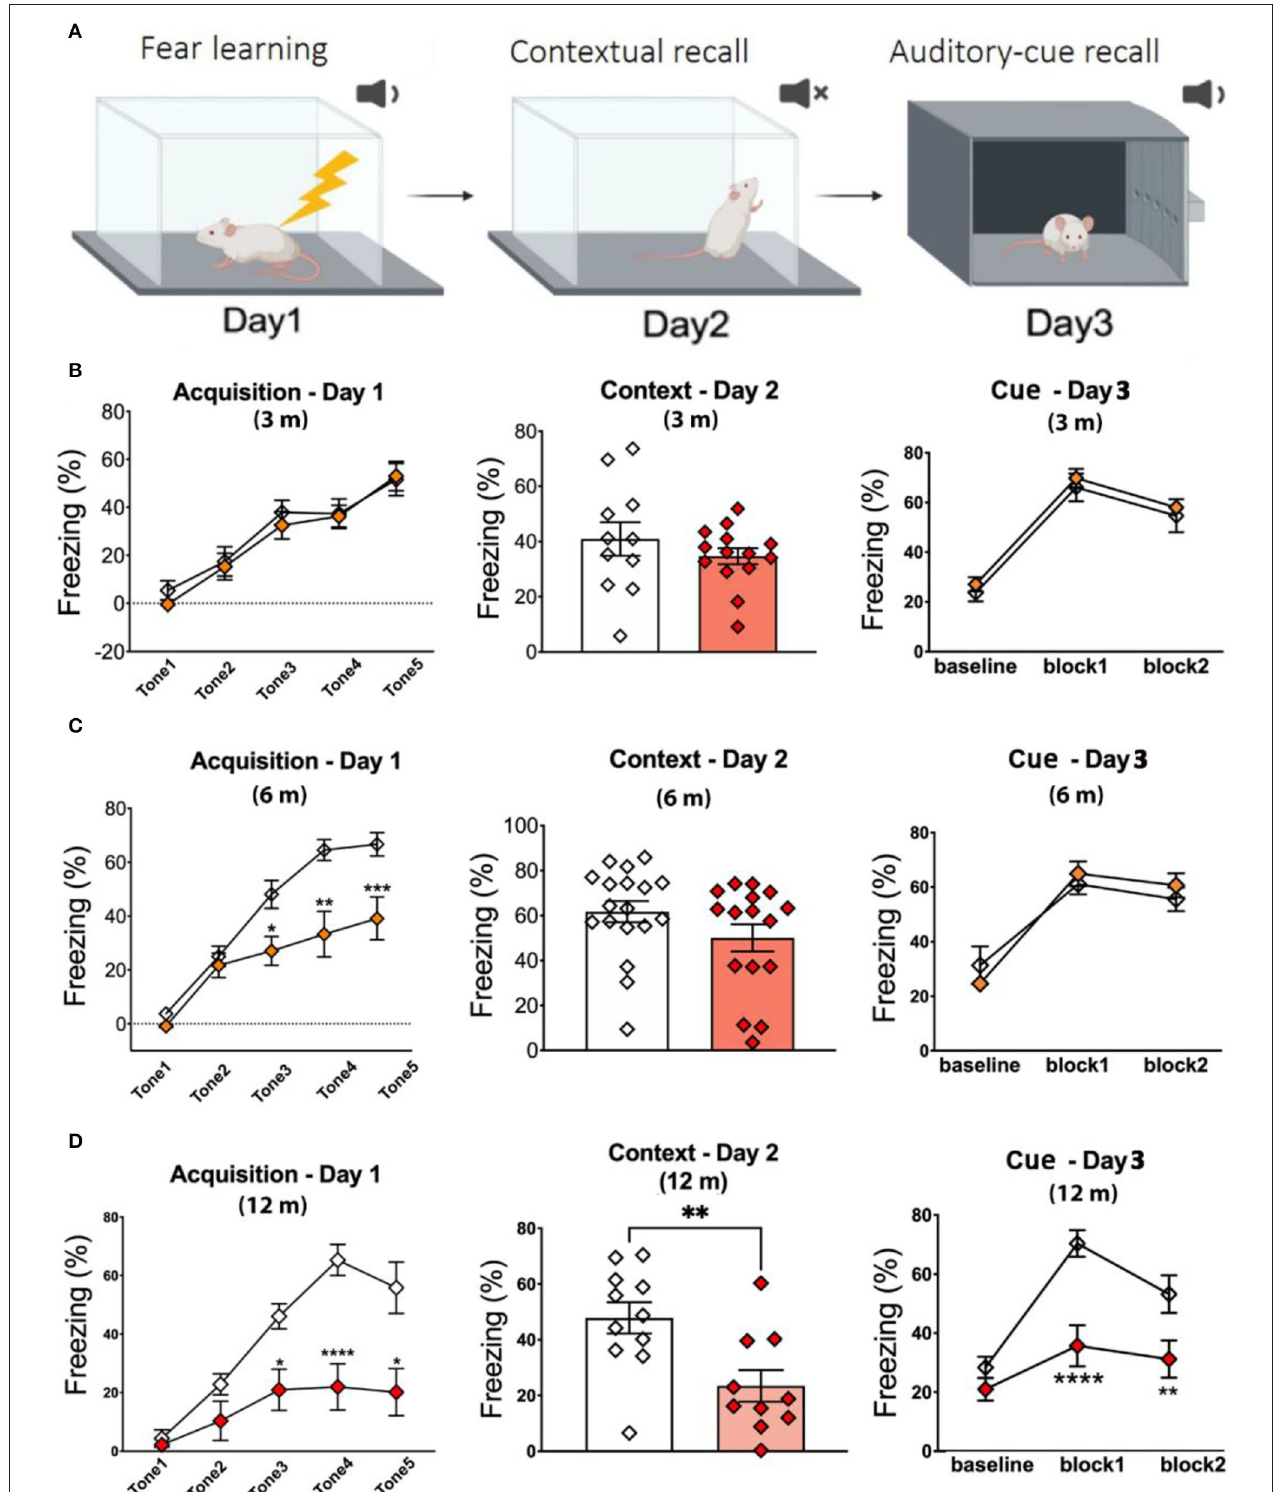
FIGURE 2 | Fear learning and memory deficit in APPKI mice. (A) Graphic illustration of fear conditioning test. (B) No deficit was observed in fear conditioning of 3-m APPKI. (C) Deficit in fear leaning was observed in 7-m APPKI. (D) Deficit from learning to contextual memory and cue memory was observed in 12-m APPKI. Data are presented as mean ± SEM; n = 10–16 mice per group. Data were analyzed using Student’s t -test for day-2 analysis and one-way ANOVA followed by Bonferroni’s multiple comparisons test for day-1 and day-3 analysis. Significance was assumed when p < 0.05. * p < 0.05, ** p < 0.01, **** p < 0.001.